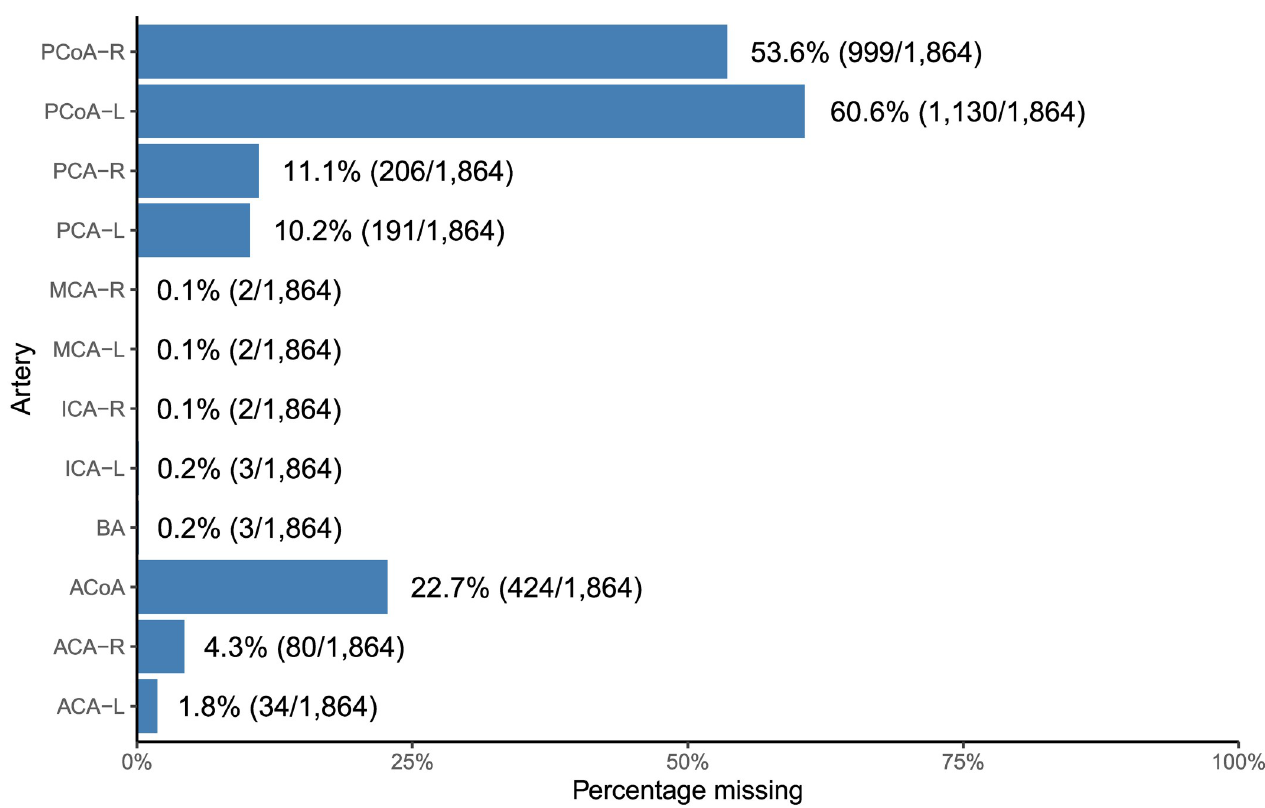
Fig 4. Frequency that each artery is missing independently of Circle of Willis variants and other arteries. Nominators and denominators are in corresponding parentheses, and represent respectively the number of times an artery is missing and the total number of subjects. ACA: Anterior cerebral artery. ACoA: Anterior communicating artery. PCoA: Posterior communicating artery. PCA: Posterior cerebral artery. ICA: Internal carotid artery. MCA: Middle cerebral Artery. BA: Basilar artery. Hemispheric left and right lateralization are denoted by “L” and “R”